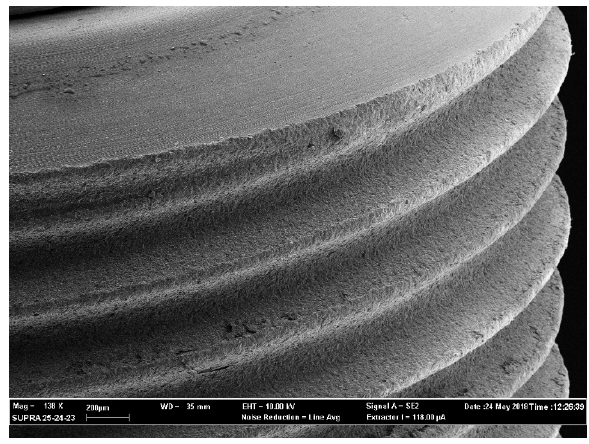
Figure 6. Air polishing and CHX treatment on a sandblasted implant. Magnification 138×.